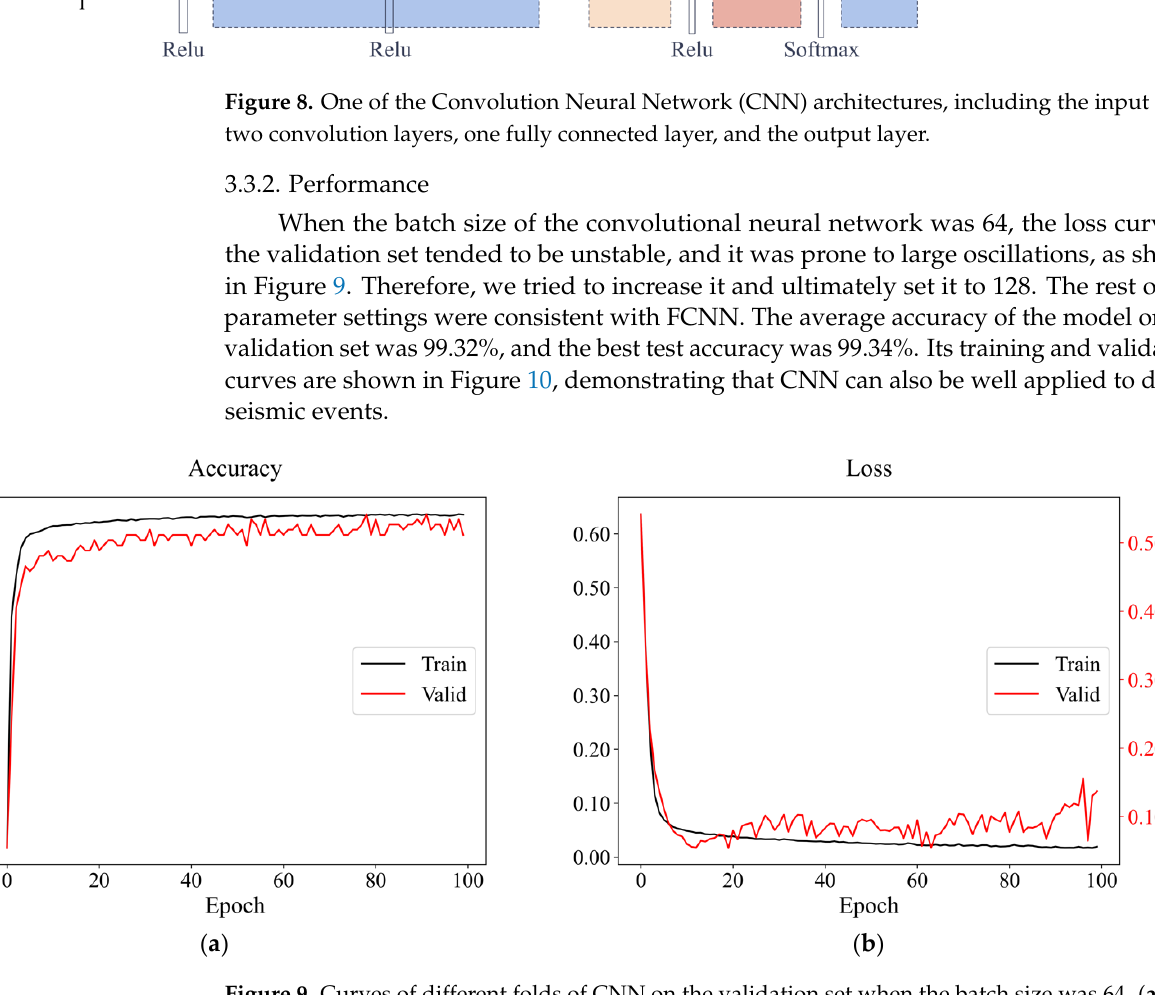
Figure 9. Curves of different folds of CNN on the validation set when the batch size was 64. ( a ) The accuracy curve of K = 7; ( b ) the loss curve of K = 8.